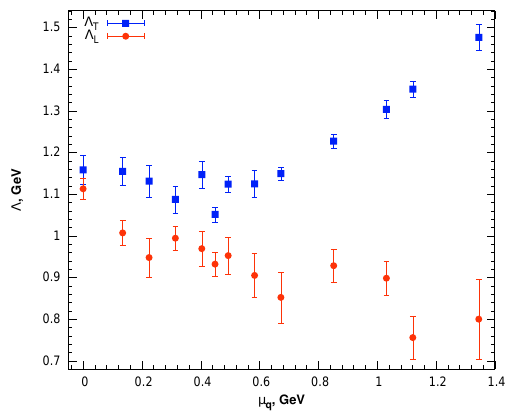
Figure 5. The parameter Λ from formula (21) for the transverse and longitudinal dressing